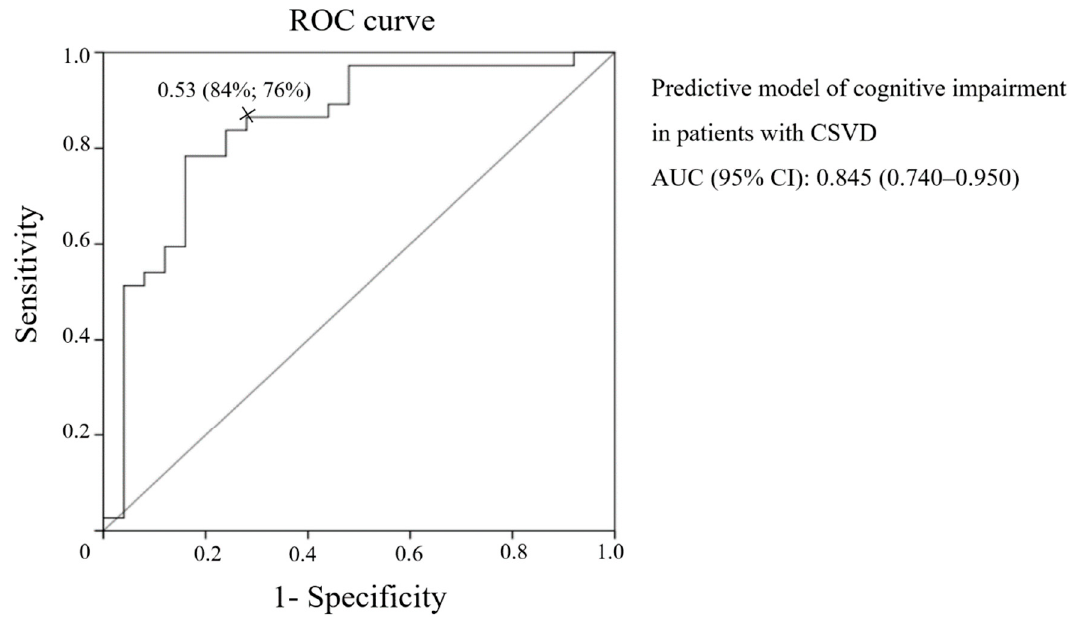
Figure 2. Receiver operating characteristic (ROC) curve of the predictive model of CI in patients with CSVD.